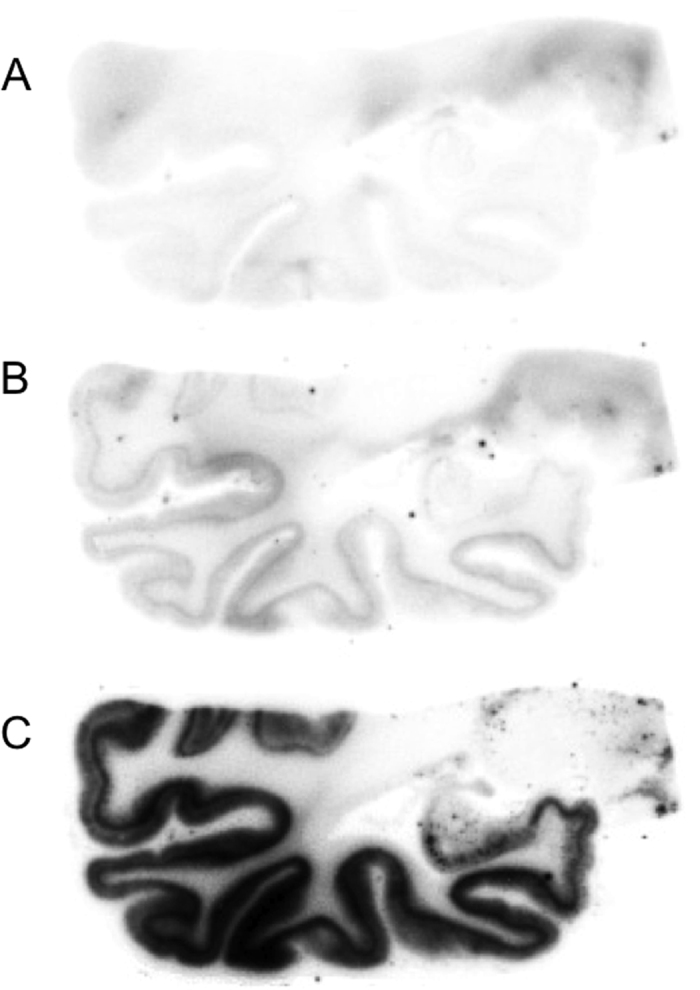
In vitro autoradiograms of [125I]BIP-NMe2 on AD brain sections with excess BIP-NMe2 of 10 μM (A) and 1 μM (B) or without BIP-NMe2 (C).